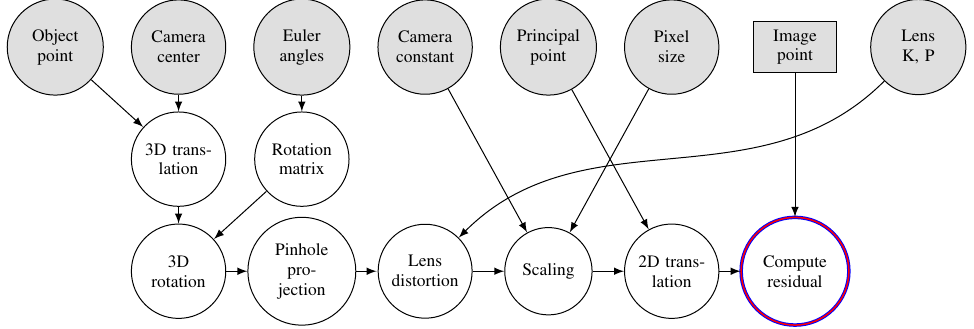
Figure 3: The DBAT implementation of the Computer Vision formulation of the Brown (1971) lens distortion model (Tsai, 1987; Heikkil¨a and Silv´en, 1997; Zhang, 2000). The Brown polynomials are used to ”add” lens distortion to the projected ideal point in normalised units before the coordinates are scaled directly to pixels. The residual (thick circle) is computed between the measured point and the ideal projected point with added lens distortion. The same modules have been used as in Figure